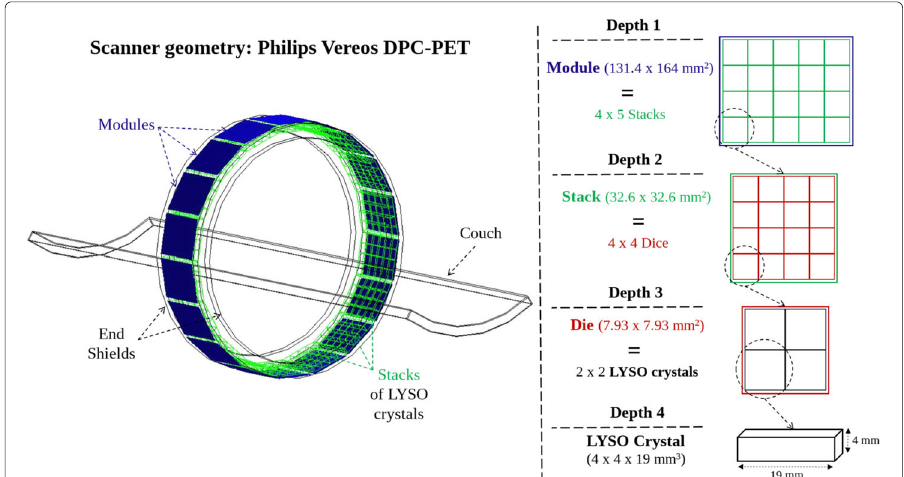
Fig. 1 GATE geometry model of the Philips DPC-PET. The four depth levels components are illustrated on the right of the image. Eighteen modules are repeated in one ring. Each module contains 4 tangentially × 5 axially arranged stacks. Each stack is subdivided into 4 × 4 dice and each die contains 2 × 2 LYSO crystals. The system is composed of a total of 23 040